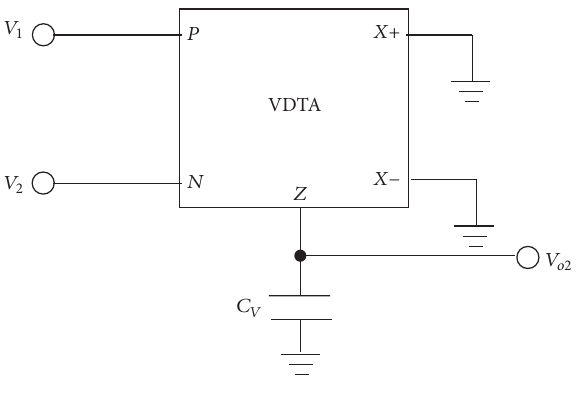
Figure 6: Lossless integrator using VDTA.